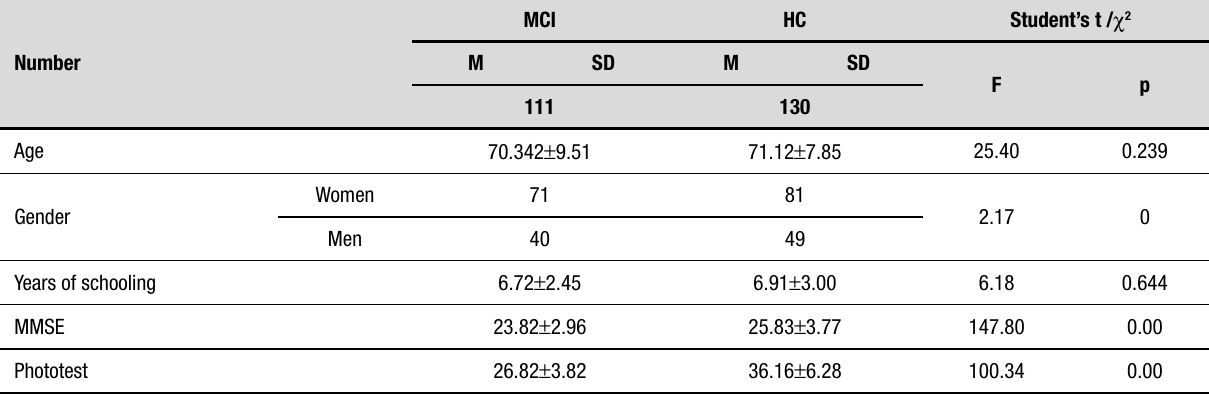
Table 1. Demographic characteristics and results of the cognitive tests of the participants.